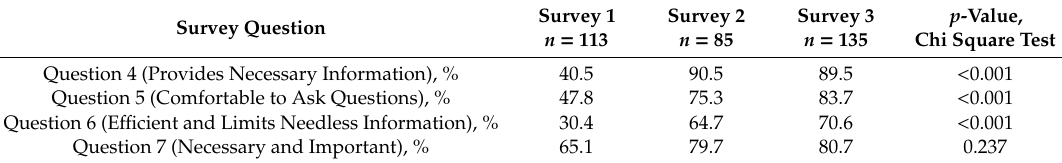
Table 2. Percentage of participants who agreed or strongly